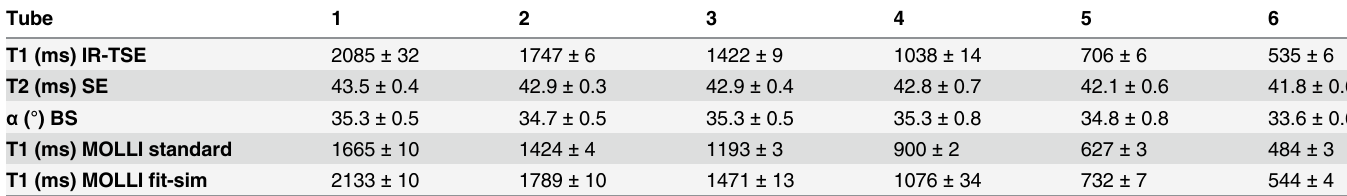
Table 2. Values ( ± standard deviations) of true T1, true T2 and excitation flip angle parameters measured on the Gd-DOTA doped phantoms by the gold-standard sequence, and T1 values derived from both post-processing methods of the MOLLI sequence.